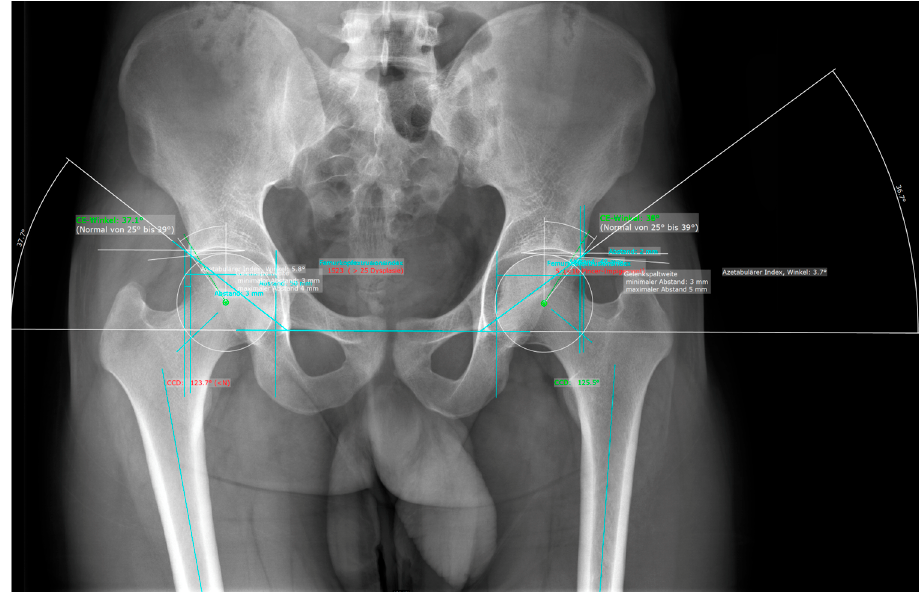
Figure 1. Representative image of the manual measurements for an AP radiograph of the pelvis using mediCAD ® .